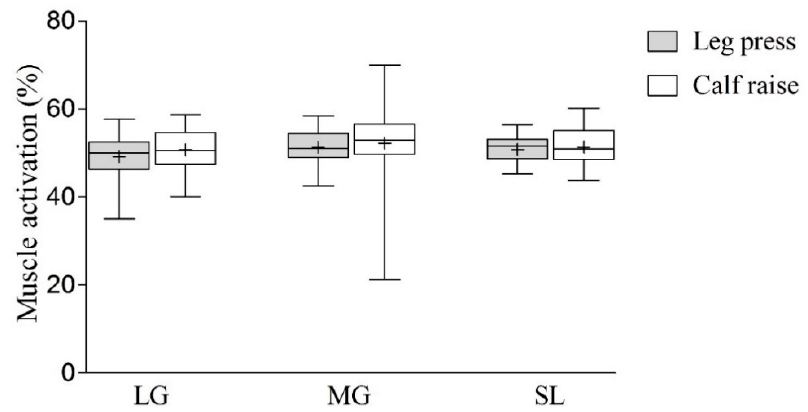
Figure 2. Comparison of muscle activation between leg press and calf raise. LG, lateral gastrocnemius; MG, medial gastrocnemius; SL, soleus. Values are presented as median (lines) with interquartile range (boxes) ± range (minimum and maximum) and + indicates mean.